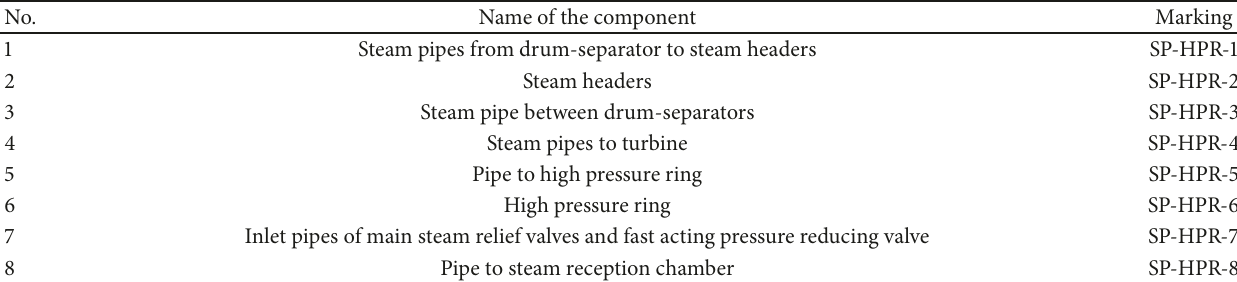
Table 1: Main SP-HPR